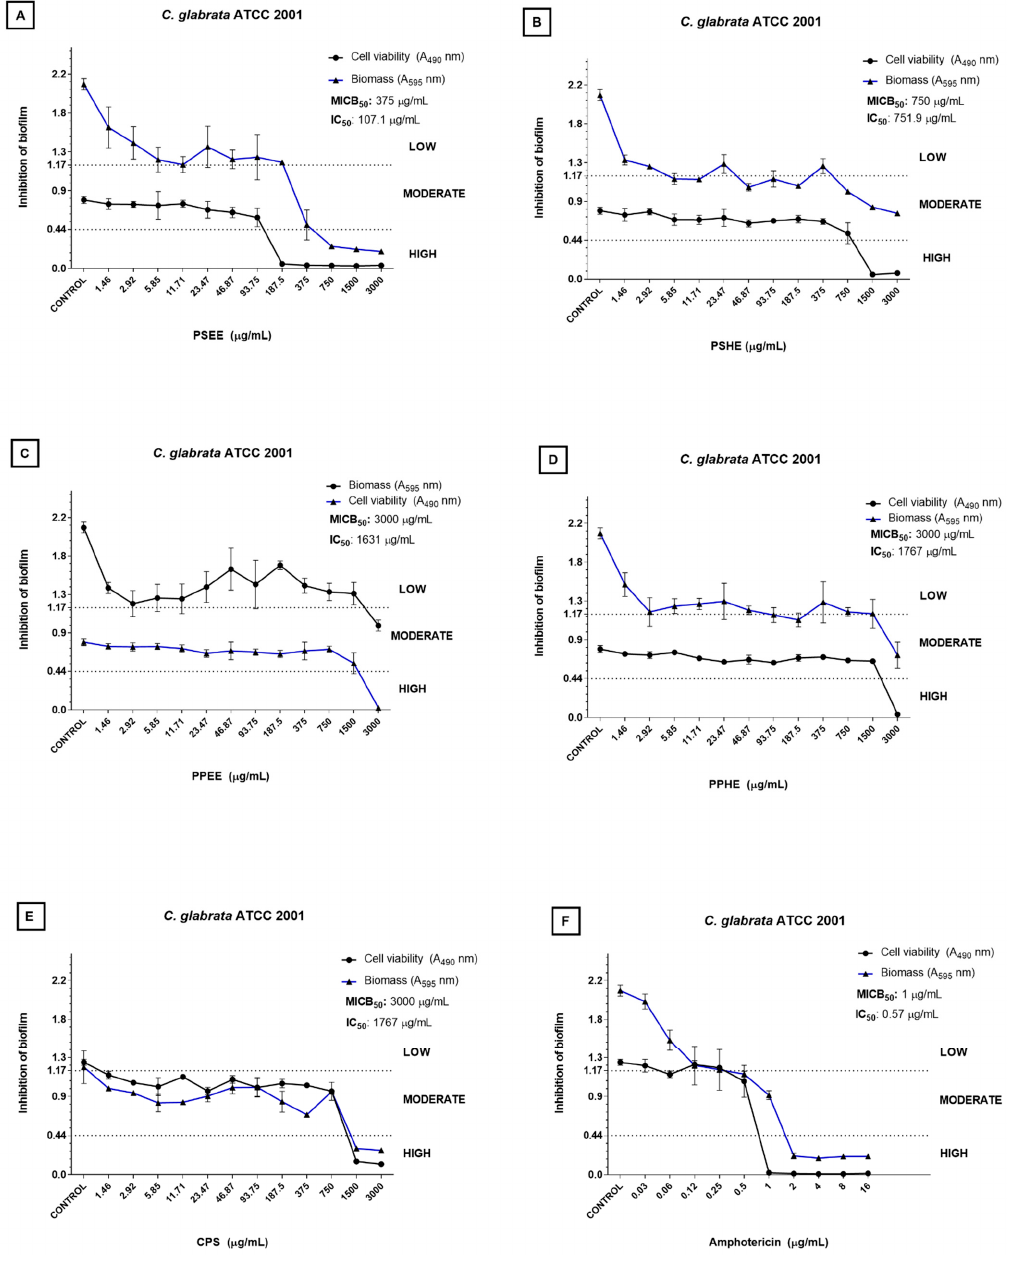
Figure 2. Inhibition of C. glabrata ATCC2001 biofilm by the hexane and ethanolic extracts from Capsicum chinense Jacq. peel and seeds ( A – D ), capsaicin ( E ), and amphotericin B ( F ). The blue line refers to the curve of the OD values of biomass in relation to the concentration of the tested sample. The black line refers to the curve of the OD values of biofilm metabolic activity in relation to the concentration of the tested sample. MICB 50 values refer to the sample concentration that inhibited biofilm formation by at least 50% in relation to the biomass [17]. The IC 50 values indicate the concentration of the sample that was able to inhibit biofilm metabolic activity by half compared to the control group [18]. The low, moderate, and high classification refers to biofilm formation inhibition in biomass, where high inhibition corresponds to OD < 0.44, moderate inhibition corresponds to 0.44 < OD < 1.17, and low inhibition corresponds to OD > 1.17. This stratification was based on the classification of Candida spp. regarding biofilm formation as proposed by Zambrano et al.